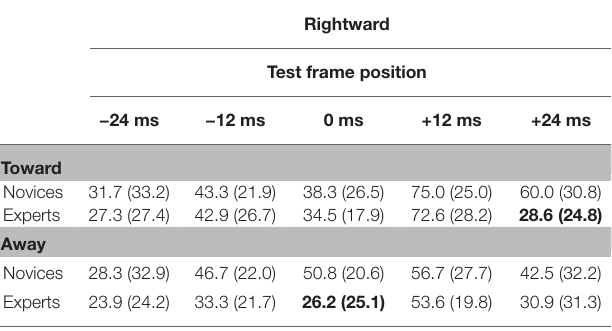
TABLE 3 | Response error rates (and standard deviations) for each group in each test frame position in the rightward direction.